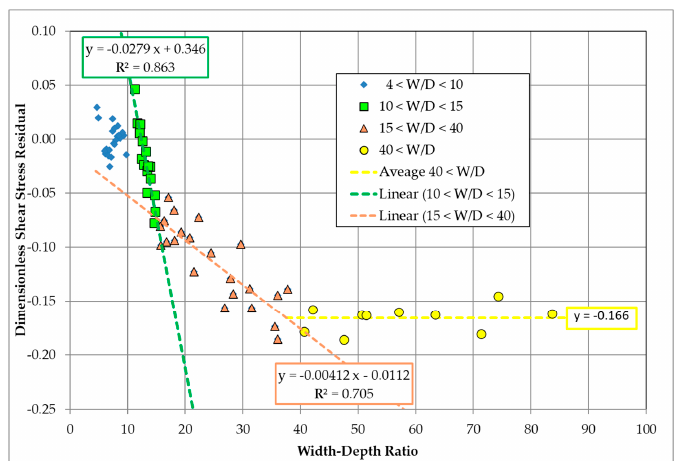
Figure 49. Residuals from all 12 simulation sets between the maximum shear stress, computed by Equation (17), and the maximum shear stress simulated by the 3D model versus the channel width/depth ratio.